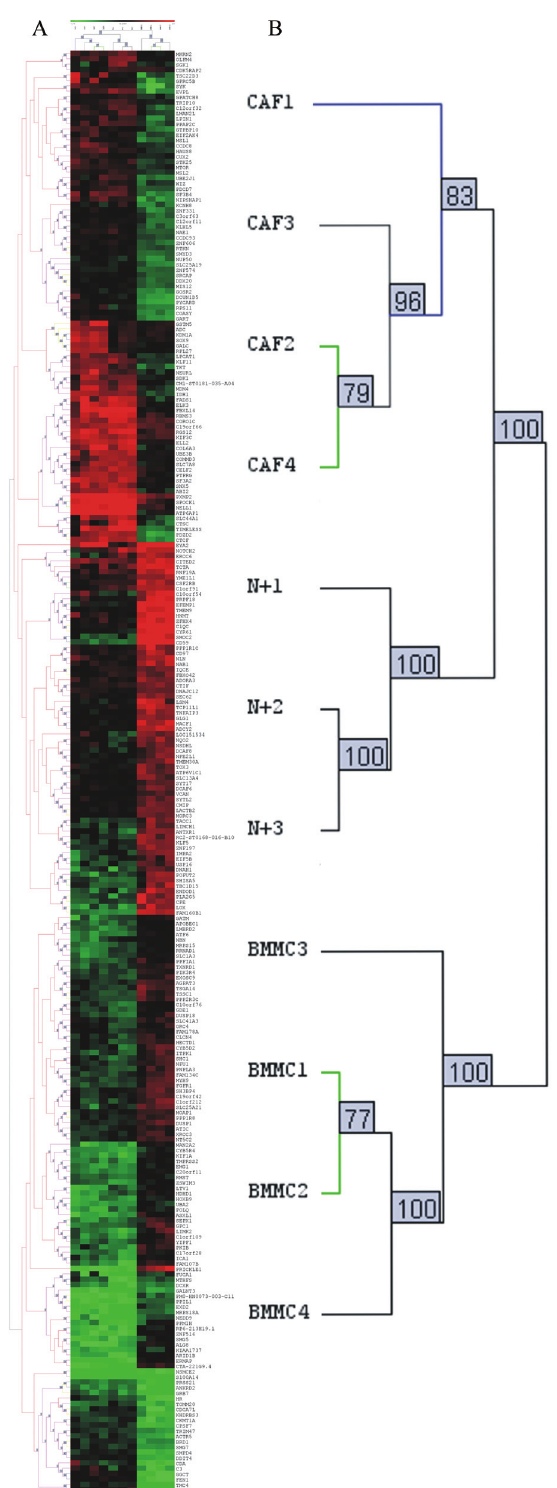
Figure 1 - Fibroblast analysis. (A) Fibroblast clustering according to cell origin. (B) Detail of the hierarchical clustering of fibroblasts from differ- ent origins based on the Euclidian distance of 267 genes differentially ex- pressed in fibroblasts obtained from breast primary tumor (CAF), lymph node (N+) and bone marrow mesenchymal cells (BMMC). The reliability values were determined by the bootstrap technique and are shown in the grayboxesinthedendrogram.Thesegenescorrectlyclusteredthesamples according to their